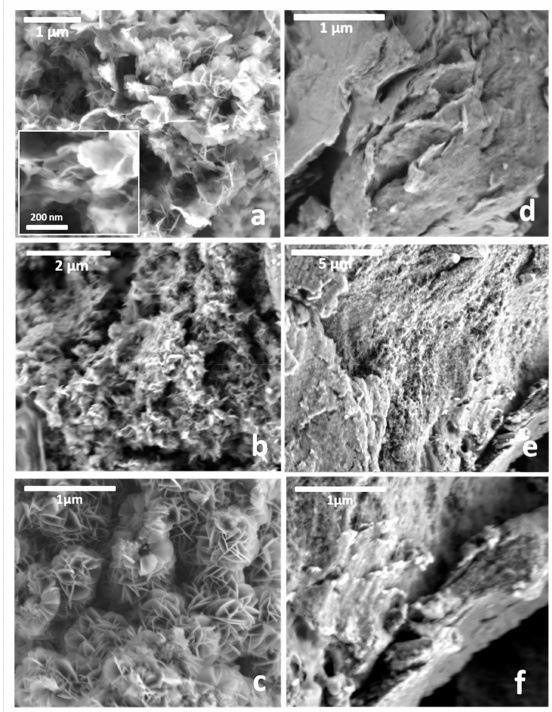
Figure 7. FE-SEM images of ( a ) MgAl–Cl, ( b ) MgAl–Nit and ( c ) MgAl-Carb LDH, as well as the ( d ) Z-LDH-Cl_cppt-US, ( e ) Z-LDH-Nit_cppt-US, and ( f ) Z-LDH_rec-US